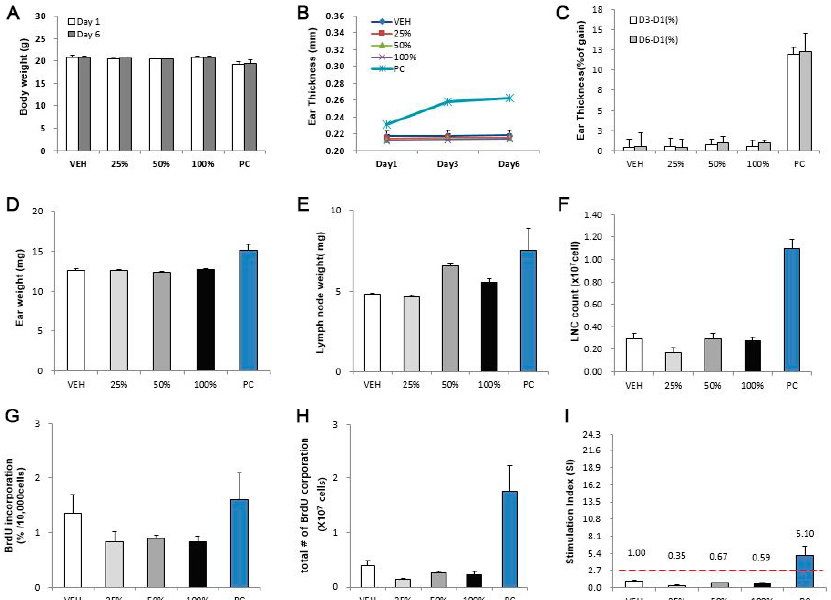
Figure 5. MWCNT skin sensitization test results in LLNA: BrdU-FCM assay. The evaluation parameters were as follows: ( A ) Body weight (g), ( B ) ear thickness (mm), ( C ) ear thickness (% of gain), ( D ) ear weight (mg), ( E ) lymph node weight (mg), ( F ) LNC count ( × 10 7 cells), ( G ) BrdU incorporation (% / 10,000 cells), ( H ) total number of BrdU corporation ( × 10 7 cells), ( I ) stimulation index (SI). Data are expressed as mean ± standard deviation values ( n =